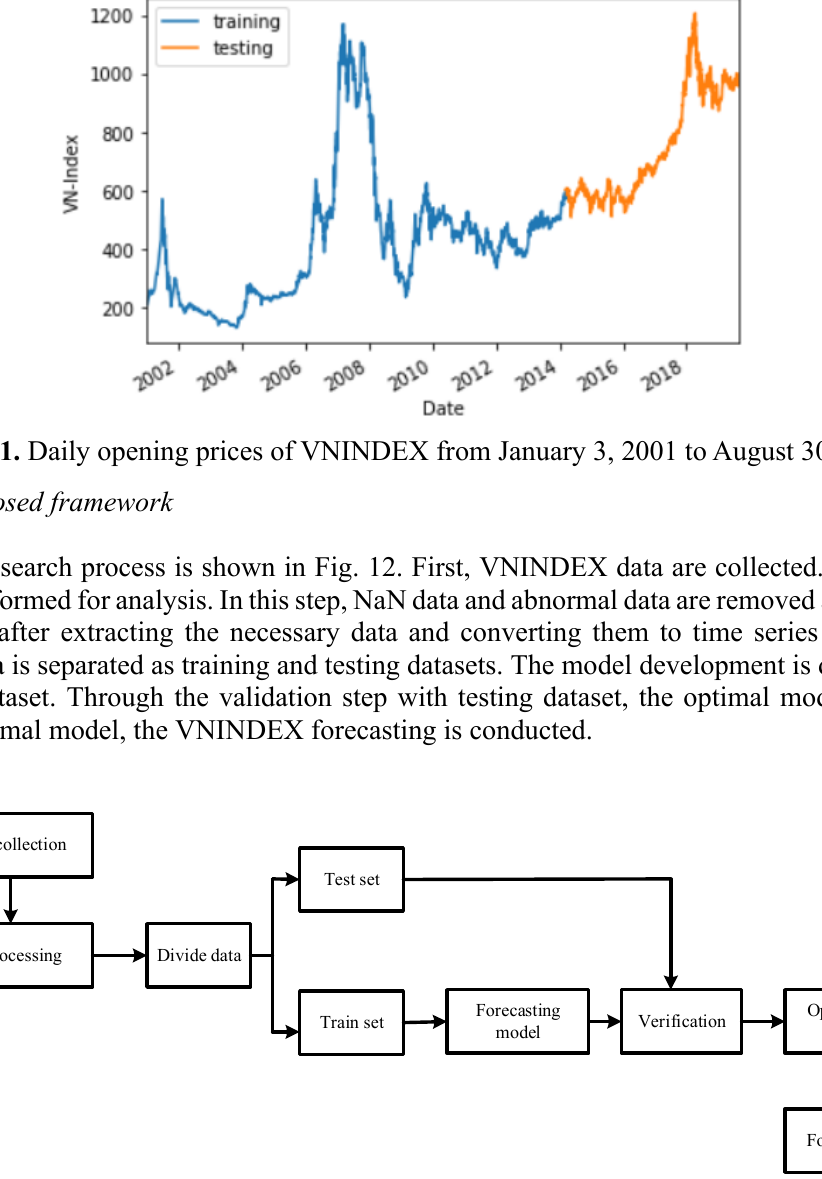
Fig. 12. The development steps of forecasting